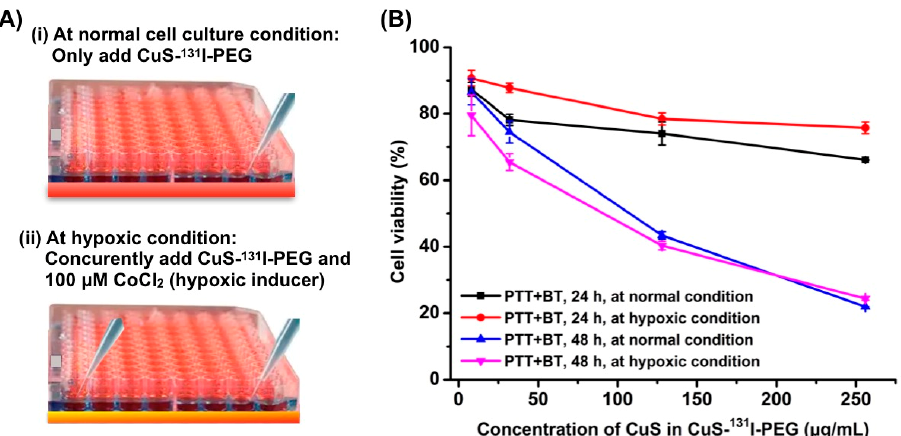
Figure 3. In vitro cytotoxicity of photothermal brachytherapy in A549 cells by CCK8 assay. ( A ) Schematic illustration of two different cell culture conditions. ( B ) In vitro cell viability of CuS- 131 I- PEG nanotheranostics under NIR laser irradiation under normal cell culture conditions and hypoxic conditions, respectively.